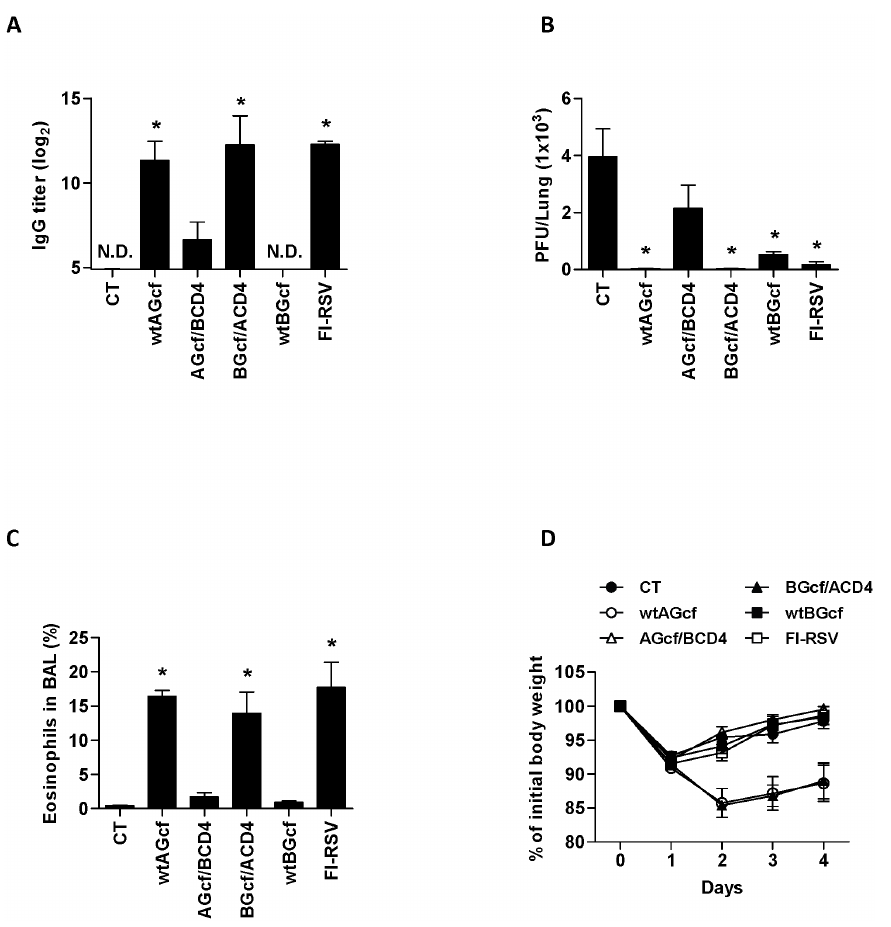
Figure 2. Effect of CD4 + T cell epitope on immune response and pathogenesis induced by wtAGcf. Mice were immunized twice with 20 m g of wtAGcf, AGcf/BCD4, BGcf/ACD4, or wtBGcf in the presence of 2 m g of CT or CT alone sublingually or with 1 6 10 5 PFU of FI-RSV through foot- pad route. (A) RSV A2 specific serum IgGs were measured by ELISA 13 days after the second immunization. At day 4 post-challenge with 2 6 10 6 PFU of RSV A2, (B) the viral replication in the lungs was determined by plaque assay and (C) the pulmonary eosinophils were measured and by flow cytometry. (D) Body weight loss was monitored daily after the viral challenge. The results are expressed as mean + S.E.M. for the group (n=5). The data are representative of three separate experiments. Significant differences from results with the CT are *, P ,